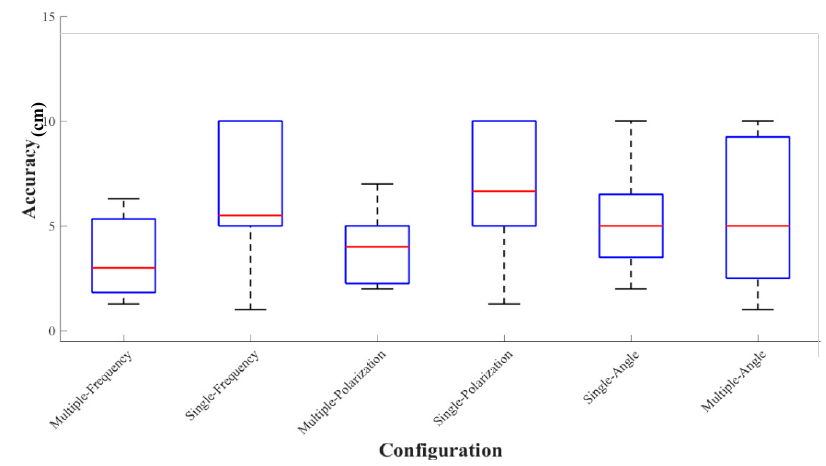
Figure 17. Effect of different SAR configuration on obtained accuracies in water level monitoring Figure 17. E ff ect of di ff erent SAR configuration on obtained accuracies in water level monitoring studies.